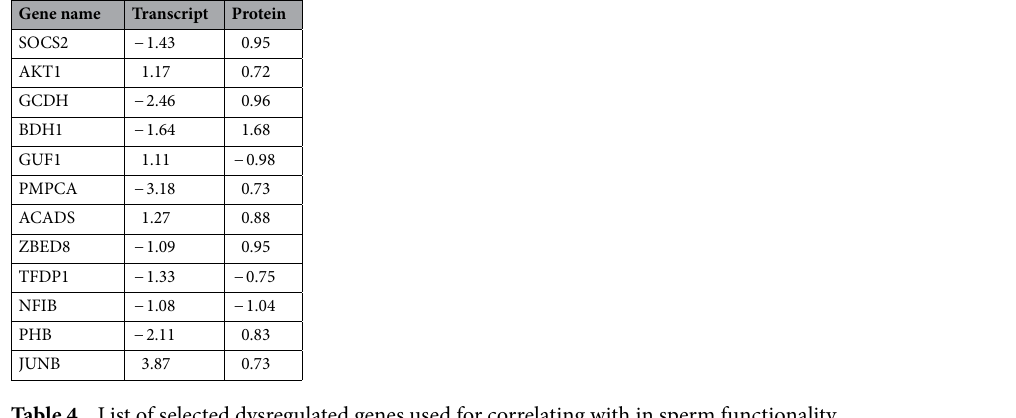
Table 4. List of selected dysregulated genes used for correlating with in sperm